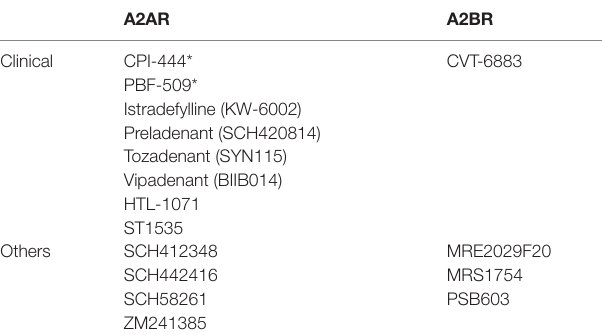
TABLe 1 | Representative A2AR/A2BR antagonists (majority of A2AR antagonists were developed for Parkinson’s disease; *under cancer clinical